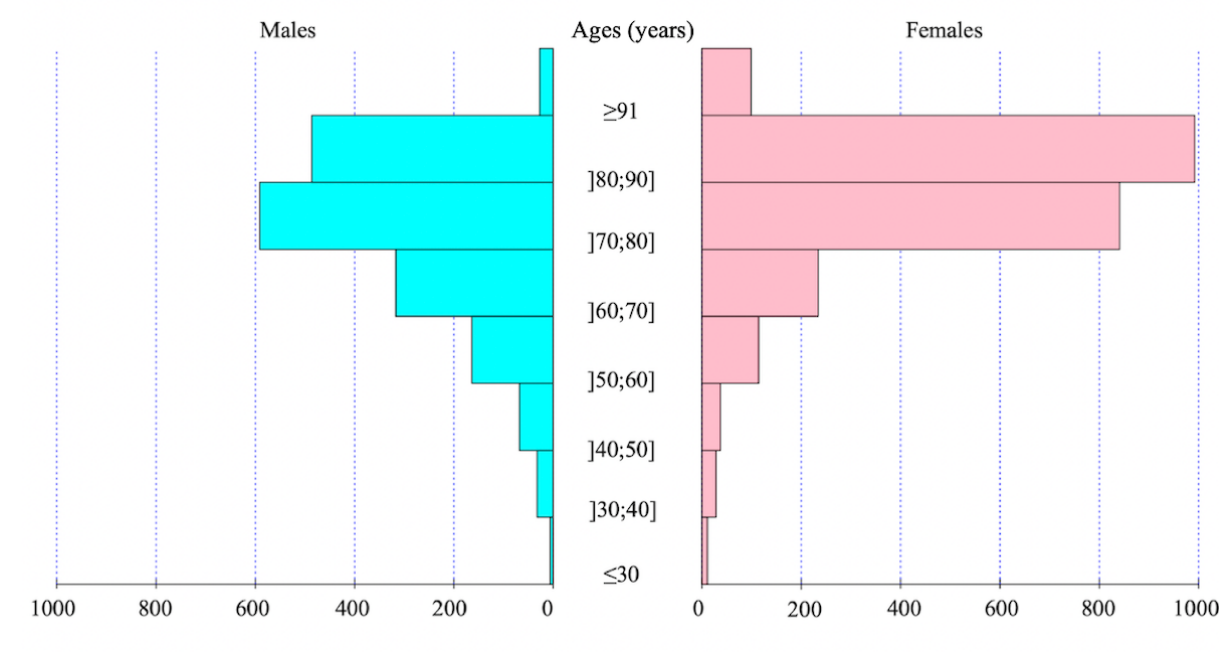
Figure 2. Age pyramid of the